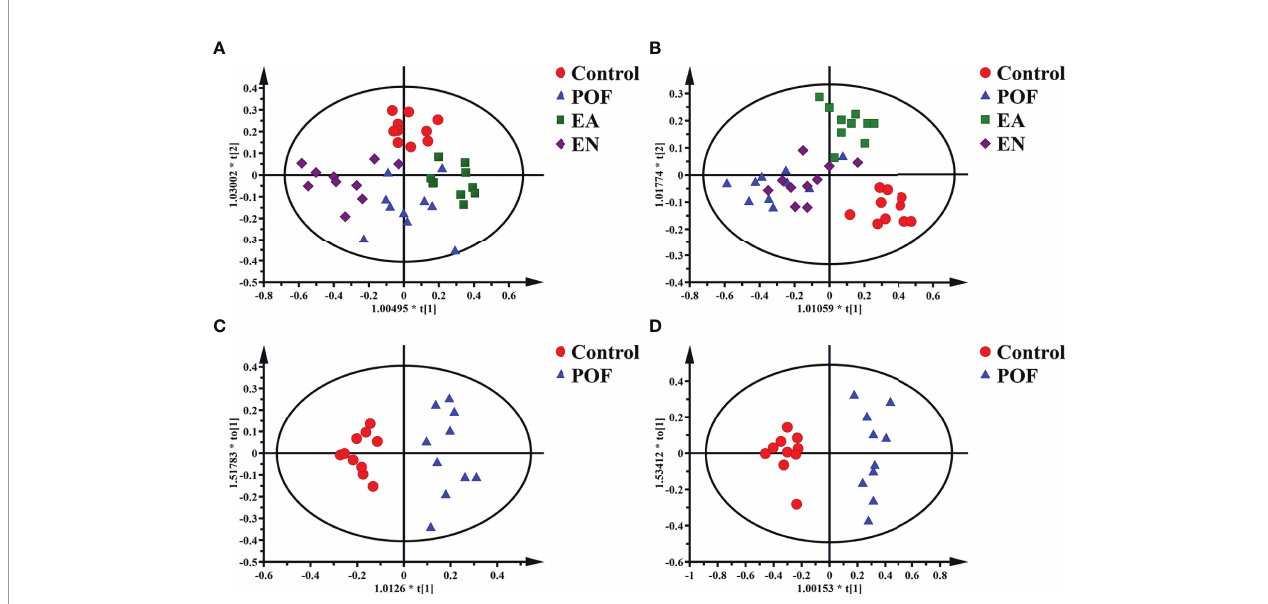
FIGURE 6 | The OPLS-DA scores plots of four groups in liver [ A , R2X(cum) = 0.632, R2Y(cum) = 0.748, Q2(cum) = 0.55] and kidney ( B , R2X(cum) = 0.498, R2Y (cum) = 0.75, Q2(cum) = 0.378]. The OPLS-DA scores plots of the control group and the POF group in liver [ C , R2X(cum) = 0.326, R2Y(cum) = 0.916, Q2(cum) = 0.621] and kidney [ D , R2X(cum) = 0.535, R2Y(cum) = 0.947, Q2(cum) =